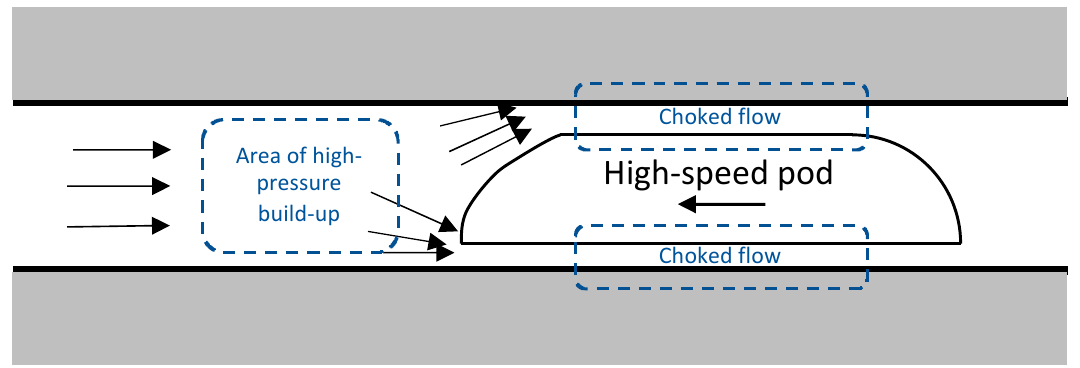
Figure 1. Pressure build-up (piston effect) in front of high-speed vehicles in tunnels. In some underground rapid transit systems, the airflow around the vehicle contributes to the ventilation of the vehicle and also makes mechanical ventilation unnecessary